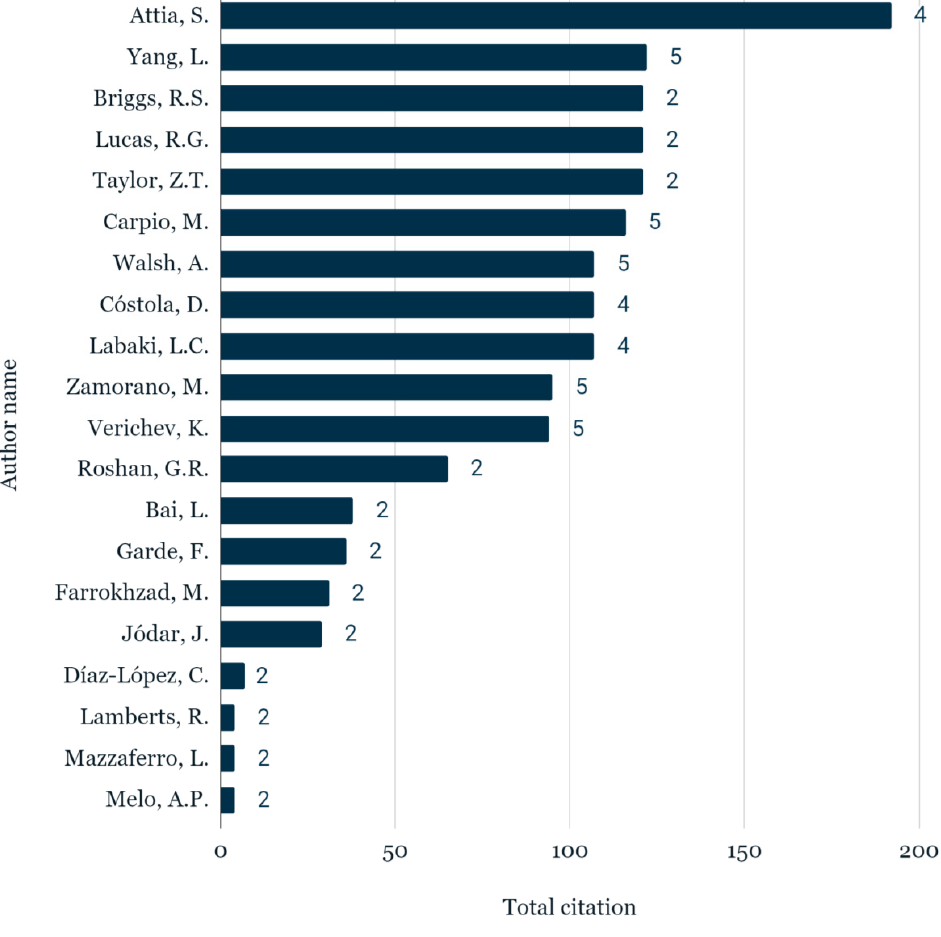
Figure 15. The bar chart of the most-contributing authors in the CZB area. The number of published CZB papers is shown at the outside end of each bar.